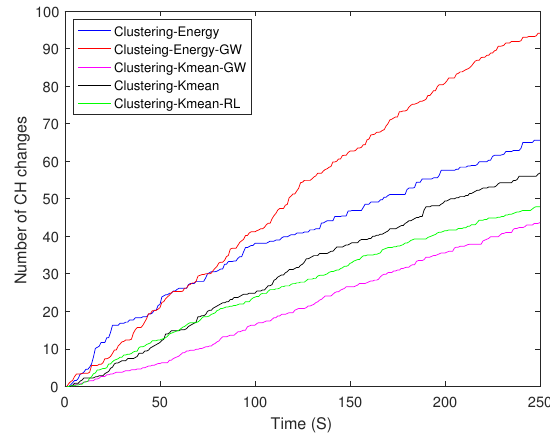
Figure 15. Number of CH changes in different clustering